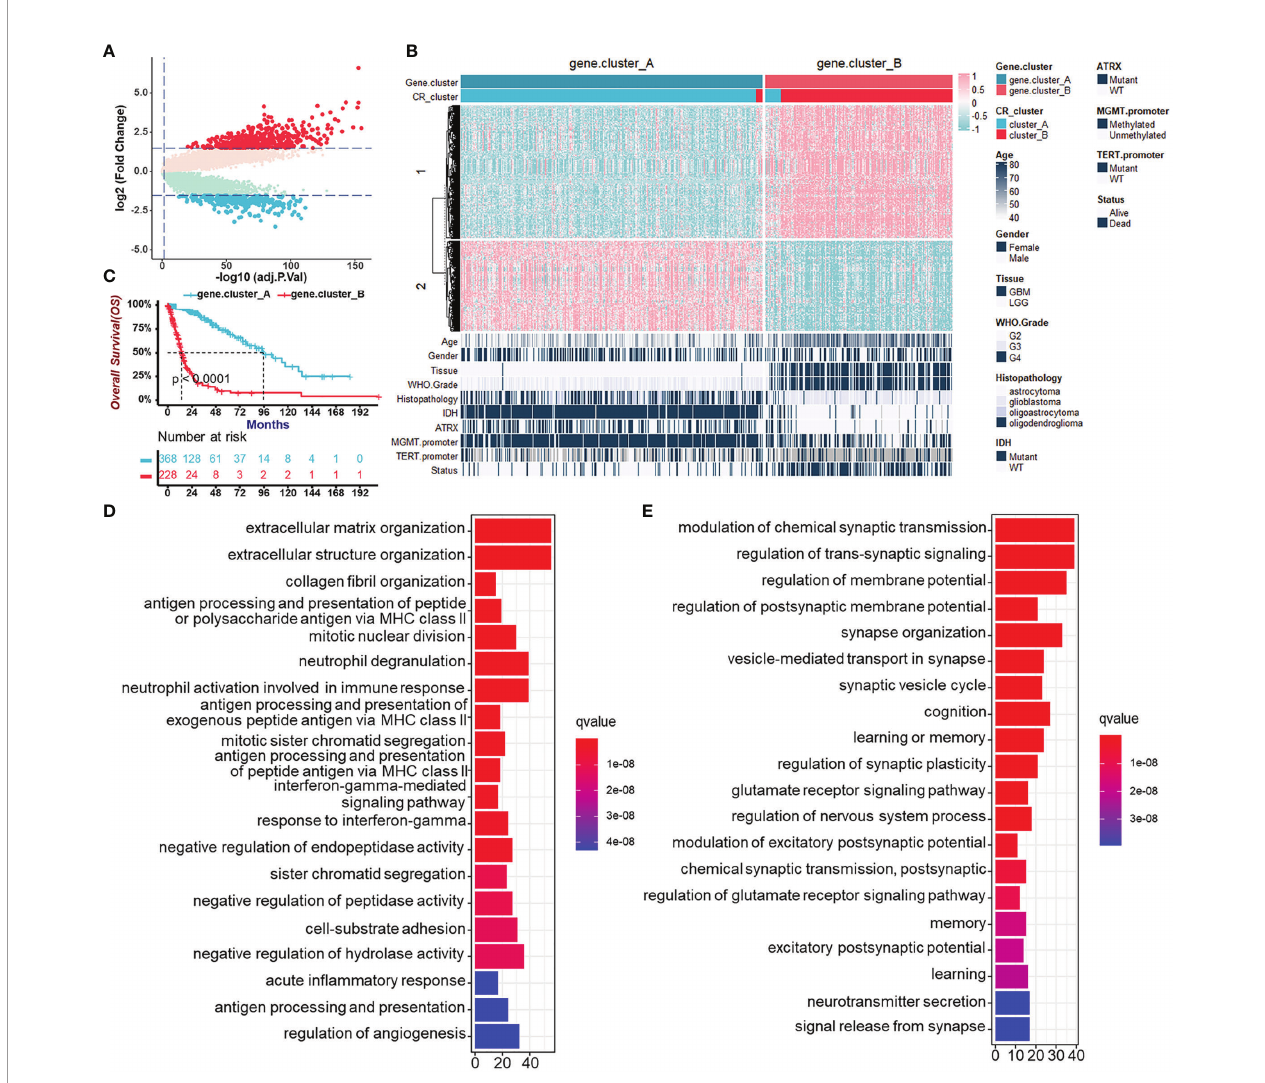
FIGURE 4 | Generation of circadian gene clusters and functional annotations for CR-related genes. (A) Volcano plot of CR pattern-related DEGs between CR cluster-A and -B (Wilcoxon test: adjust p < 0.05, and |log2FC| > 1.5). (B) Unsupervised clustering of CR pattern-related DEGs to classify patients of the TCGA cohort into different subtypes, termed CR gene cluster-A and -B, respectively. The gene clusters, CR clusters, and other parameters were used as patient annotations. (C) Survival analysis for CR gene clusters in the TCGA cohort including 368 cases in gene cluster-A and 228 cases in gene cluster-B using Kaplan – Meier curves (Log- Rank test, p < 0.0001). (D) Functional annotation for CR-related genes upregulated in gene cluster-B (Gene Set 1 in B ) using GO enrichment analysis. The length of the bar plots represents the number of genes in that category. The color depth represented q -value. (E) Functional annotation for CR-related genes upregulated in gene cluster-A (Gene Set 2 in B ) using GO enrichment analysis. The length of the bar plots represents the number of genes in that category. The color depth represented q